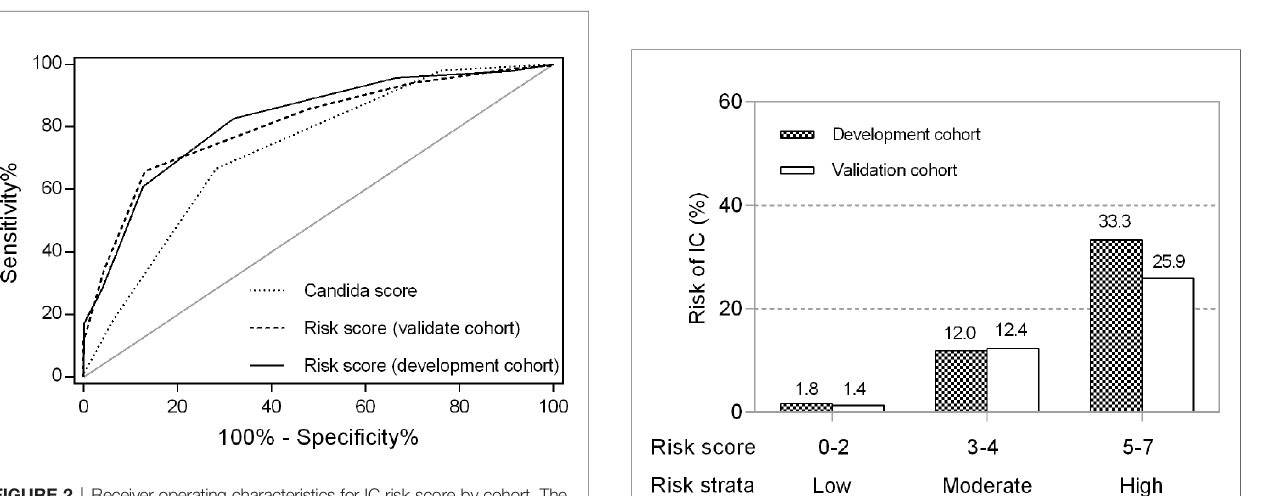
FIGURE 2 | Receiver operating characteristics for IC risk score by cohort. The area under the receiver operating characteristic (AUROC) curve was 0.820 for the development cohort and 0.807 for the validation cohort. AUROCs were similar in both the development and validation cohorts (Z=0.236, P=0.813). However, the AUROC for the risk score was larger than that of Candida score (0.820 versus 0.711, P=0.044) in the development cohort.